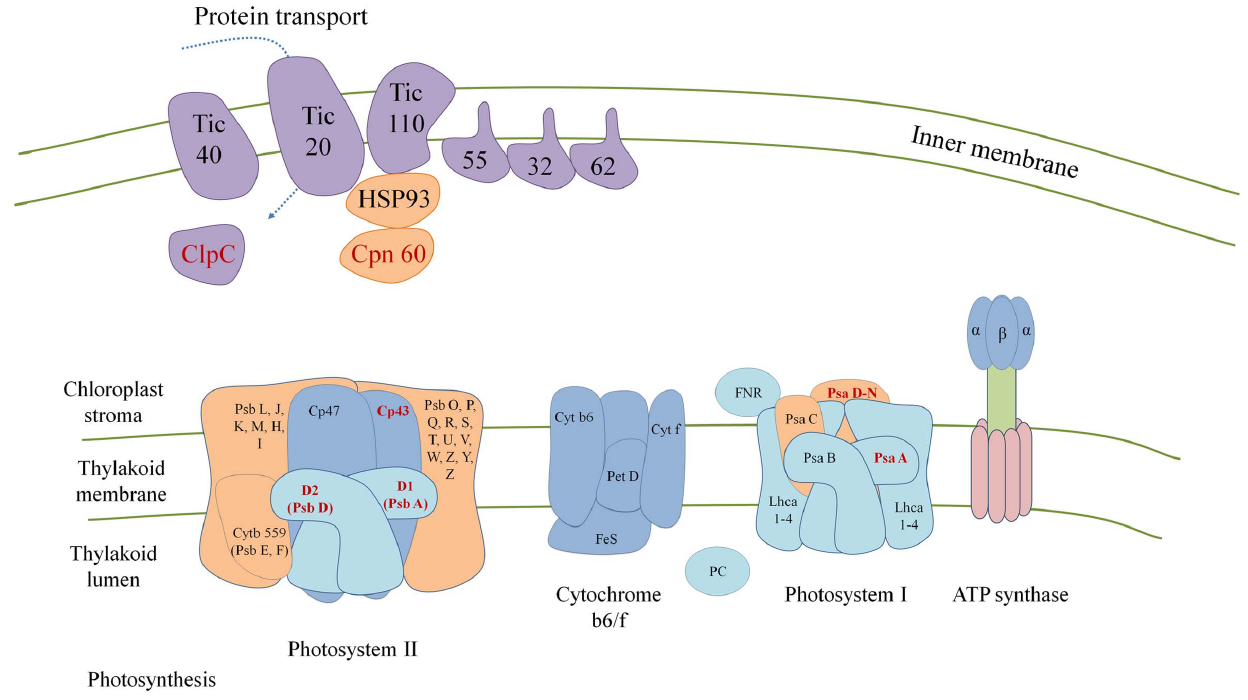
Figure 4. A diagram showing chloroplast membrane genes and light reaction center genes. The genes found in Pfiesteria piscicida EST database are marked in red color.